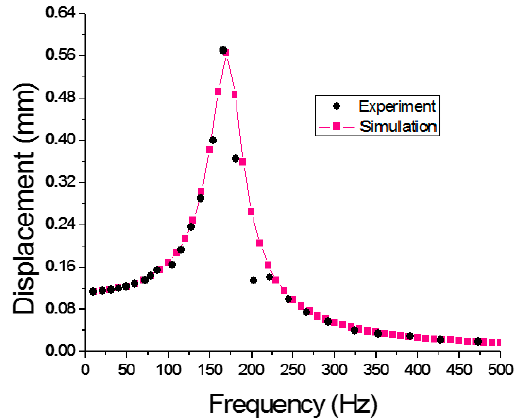
Figure 10. Displacement comparison of experiment and simulation.